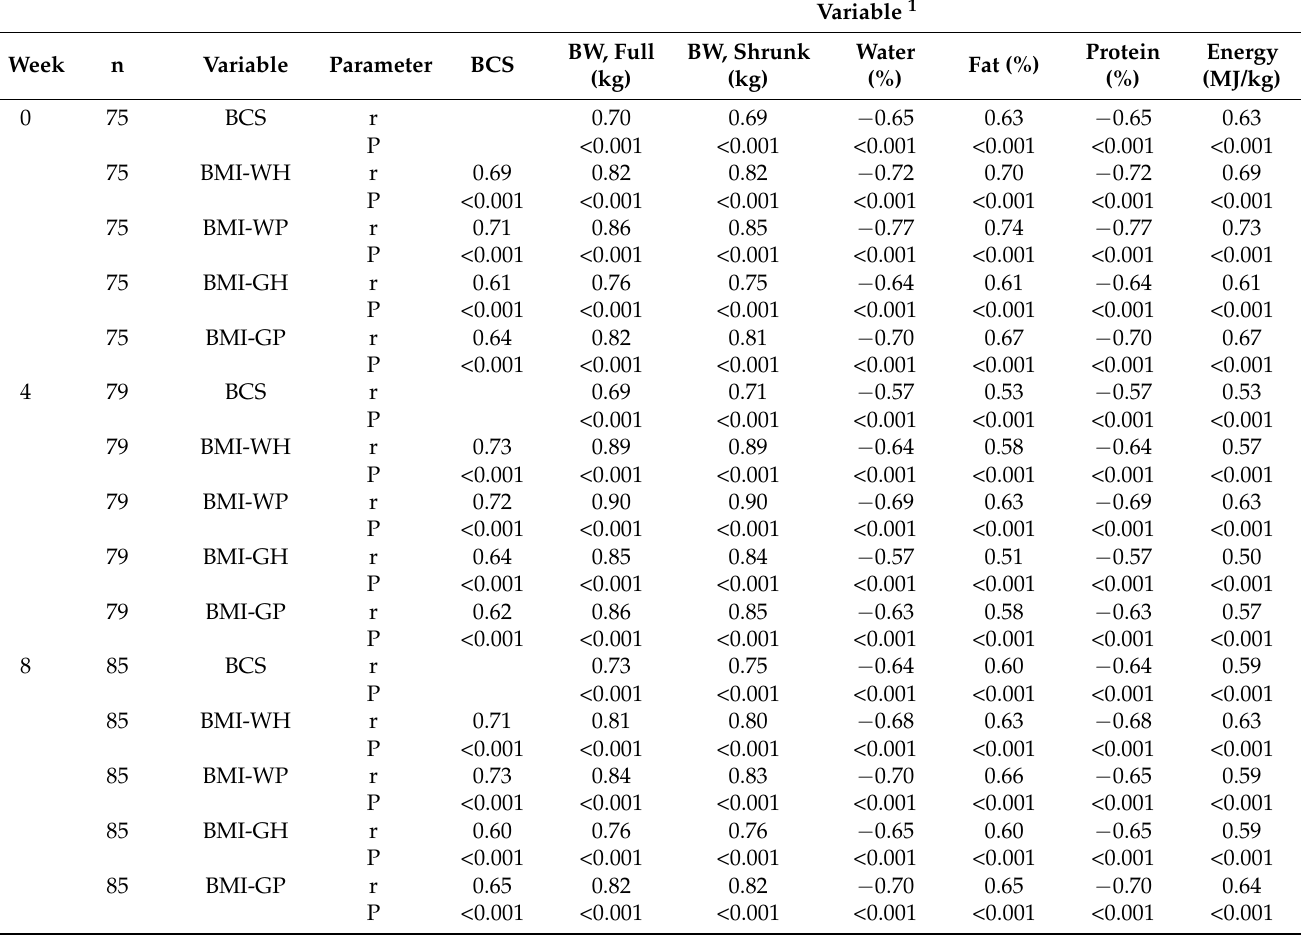
Table 8. Pearson correlation coefficient (r) between body condition score, body mass indexes, body weight, and body composition of hair sheep based on urea space measures at the beginning of the experiment and after 4 and 8 wk 1